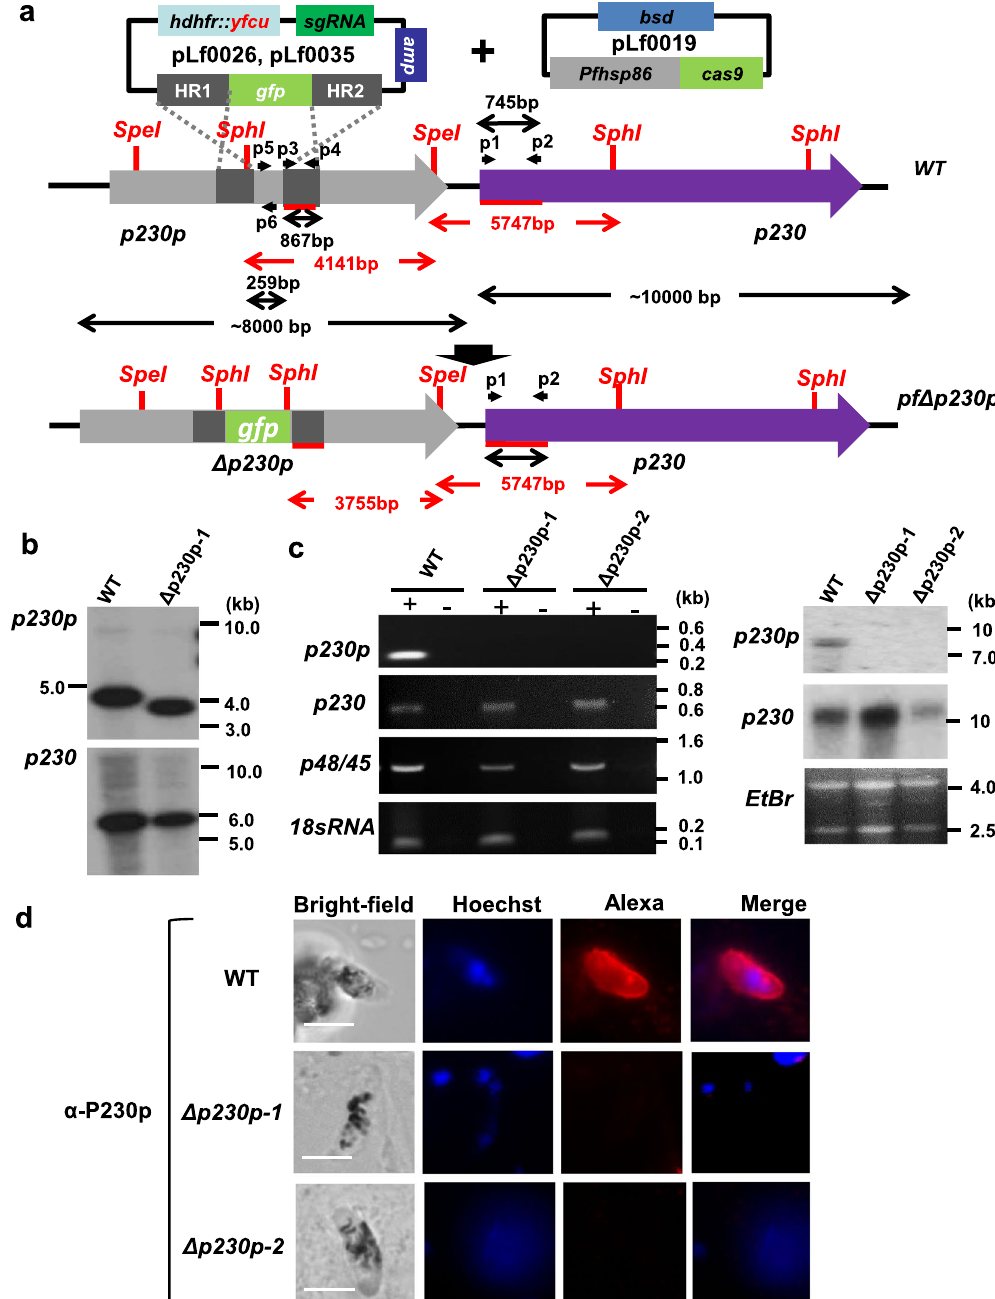
Figure 1. Generation and genotyping of Pf Δ 230p parasite lines and absence of p230p expression in Pf Δ p230p parasites. ( a ) Two Pf Δ p230p parasite lines were generated using CRISPR/Cas9 methodology as described previously 20 . The p230p gene was disrupted by insertion of a GFP-expression cassettes using plasmids pLf0026 ( cam promoter driving GFP) or pLf0035 ( hsp70 promoter driving GFP). A schematic representation of the locus containing the paralogous genes p230p and p230 , before and after insertion of the construct showing the location of the restriction sites ( Spe I, SphI ), sizes of restriction fragments (in red), location of primers (p) and the PCR amplicons and sizes of transcripts (in black) used to analyse correct disruption and transcription of the paralogous genes. ( b , c ) HR1, HR2: p230p homology regions. The figure is not shown to scale. Primer sequences can be found in Supplementary Table S1. ( b ) Southern analysis of Sph I/ Spe I restricted DNA of WT and Pf Δ p230p-1 parasites confirms the specific and expected disruption of the p230p gene locus. DNA was hybridized with a probe targeting the homology region 2 (HR2; primers p3/p4) of p230p (left panel) and a specific probe of 745 bp (primers p1/p2) of the 5 ′ p230 open reading frame (right panel). The hybridization pattern observed with first probe identified the expected different-sized DNA fragments in WT and Pf Δ p230p-1 parasites (4141 bp and 3755 bp); the second probe hybridized to a single expected fragment (5747 bp) in both WT and Pf Δ p230p-1 , indicating an unaltered p230 locus. Uncropped images of the